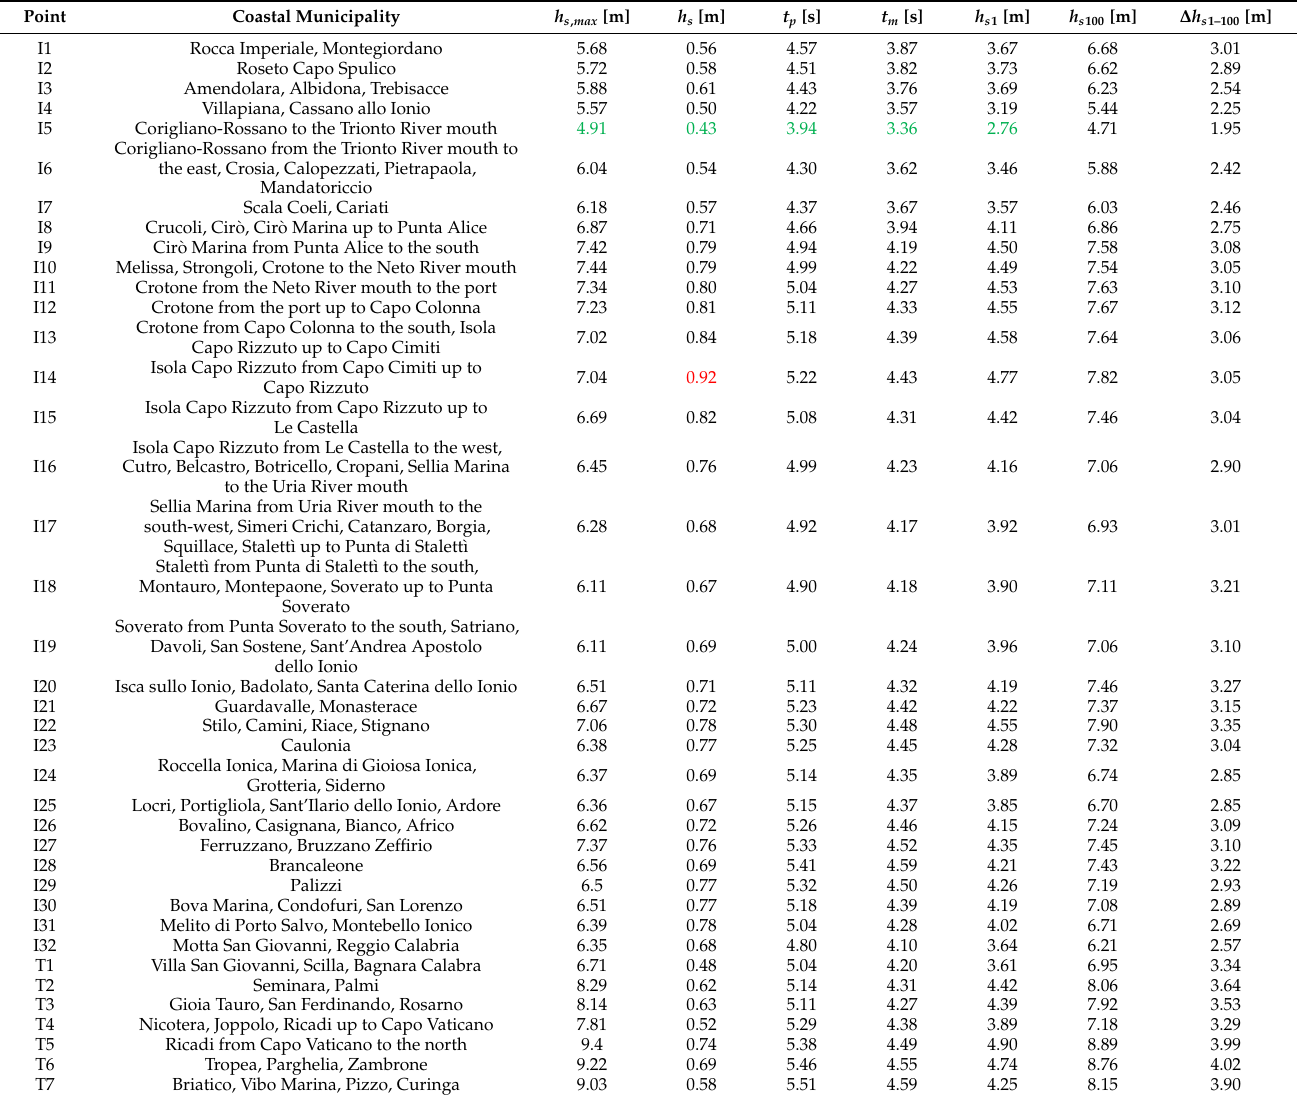
Table 1. Coastal municipalities present in the coastal area corresponding to each point and the values of maximum significant wave height h s , max , average significant wave height h s , average peak period t p , average mean period t m , significant wave height of return period of 1 year h s 1 , significant wave height of return period of 100 years h s 100 , and difference between significant wave height of return period of 1 and 100 years ∆ h s 1–100 , calculated for each point. Legend: the higher values are in red, and the lower values are in green.